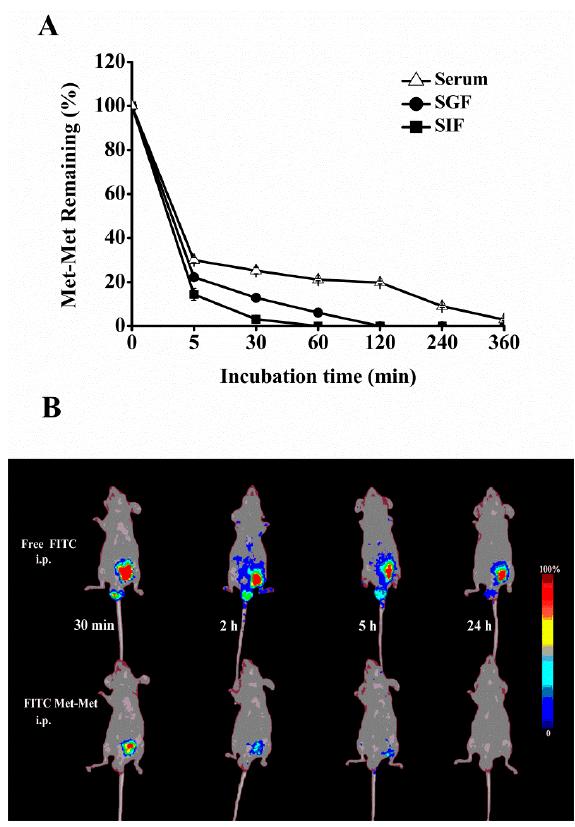
Figure 1. Stability of methionyl-methionine (Met-Met) in biological fluids and in vivo spectral fluorescence imaging of nu/nu mice. Met-Met disappearance (%) was measured after Met-Met was incubated in gastric fluid (SGF), intestinal fluid (SIF), or serum for 5–360 min in vitro ( A ). Live animal fluorescence imaging was performed in nu/nu mice after they were intraperitoneally (i.p.) injected with either Free-FITC or FITC-labeled Met-Met for 30 min–24 h ( B ). Data with error bars represent the mean ± SEM, n = 3.